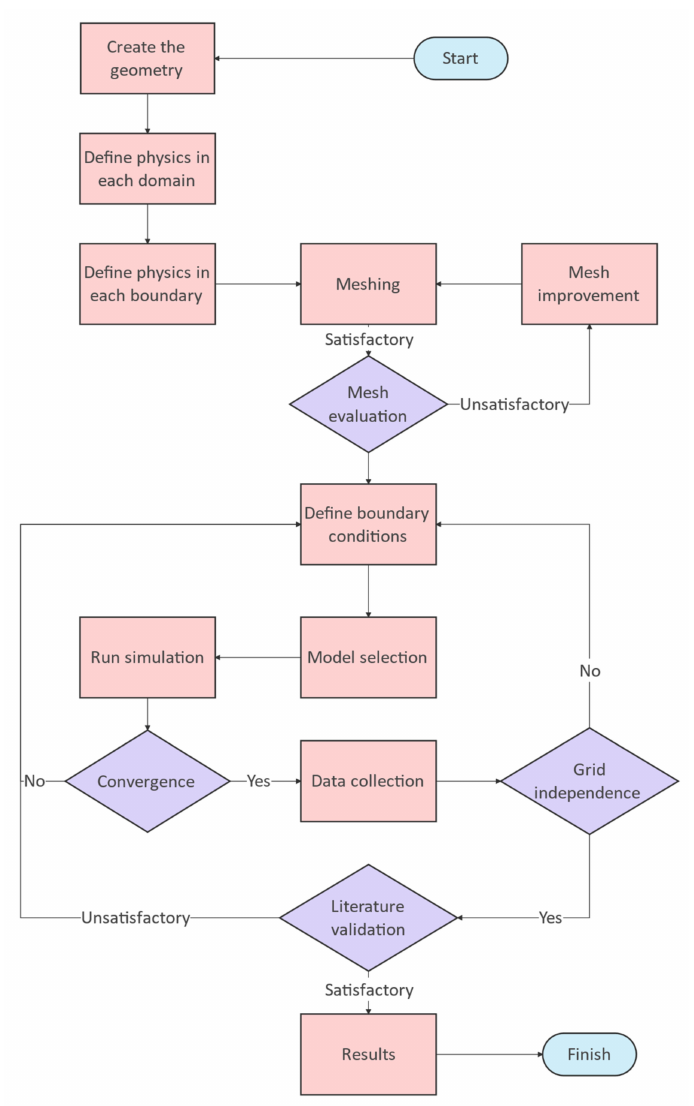
Figure 8. The flowchart of simulation procedure to perform the CFD analysis of the TEG unit. Empirical relationships were derived to calculate during post-processing the TEG electrical performance under the thermal conditions simulated by the CFD